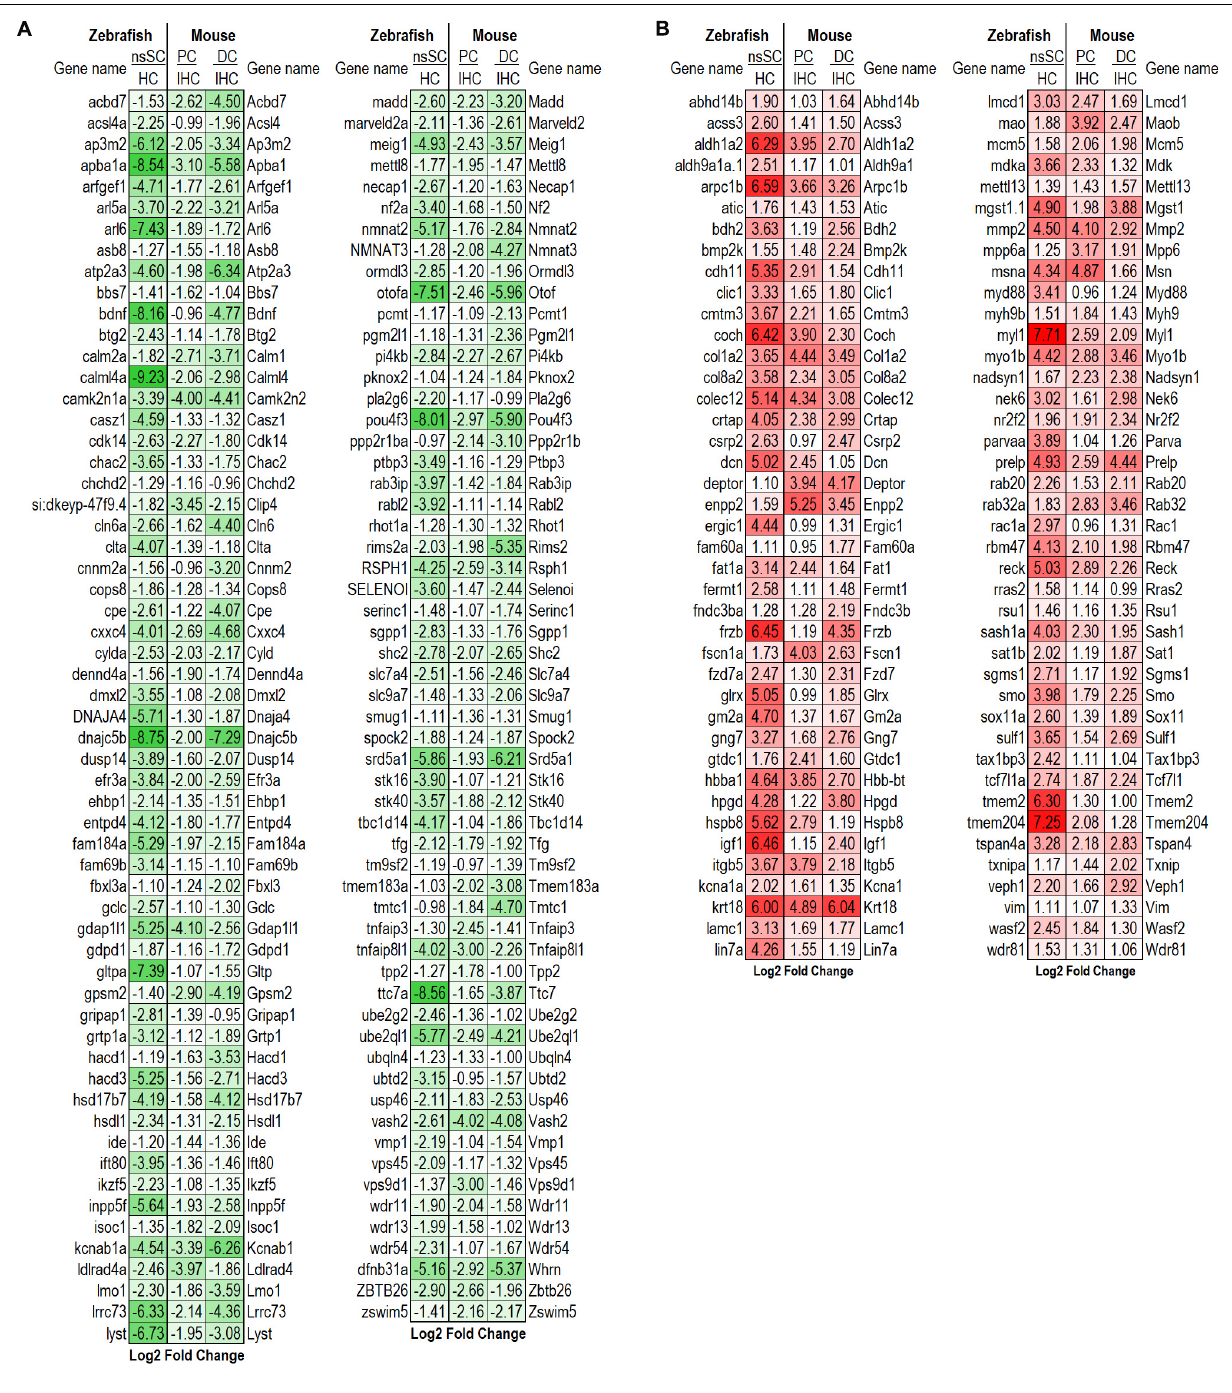
and locomotion, epithelium development and regulation of epithelial cell proliferation, neurogenesis, and cell/embryo development ( Supplementary Data Sheet 3 ). This